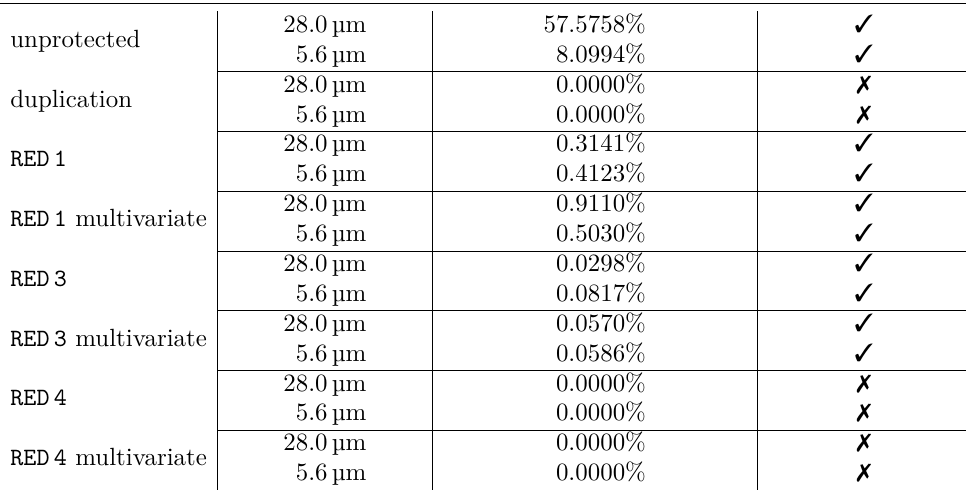
Table 2: Results of our fault injection experiments targeting the SKINNY cores for key extraction via DFA using two different spot sizes. Only unique and informative faults are